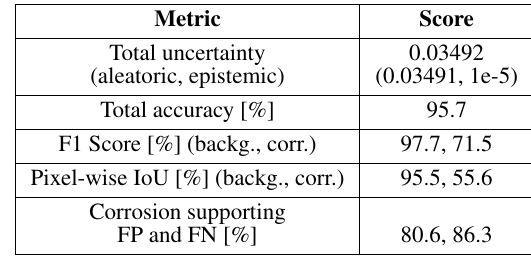
Table 1. Results of best Deeplab V3+ segmentation network